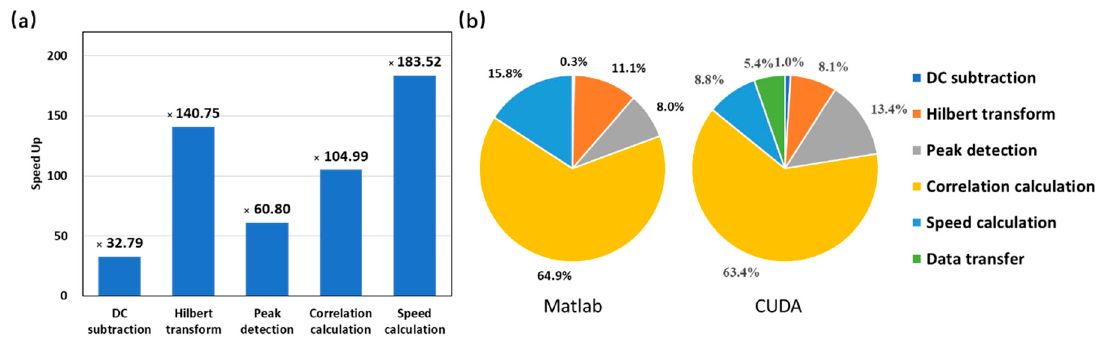
Figure 10. Analysis of the implementation results. (a) Speedup of each step. (b) Runtime analysis.